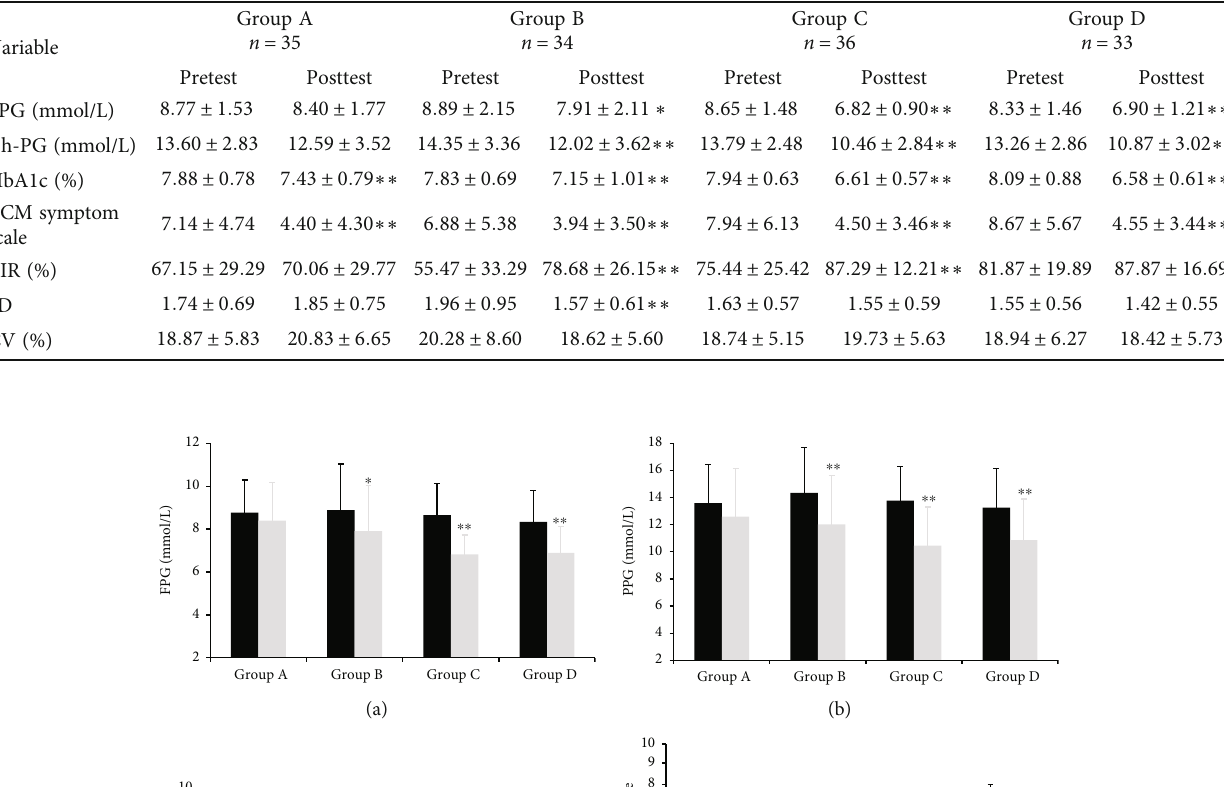
Table 2: Glycemic changes pre- and postinvention.